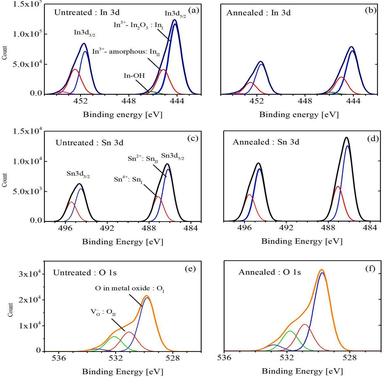
XPS In 3d, Sn 3d, and O 1s spectra of the untreated and annealed films.